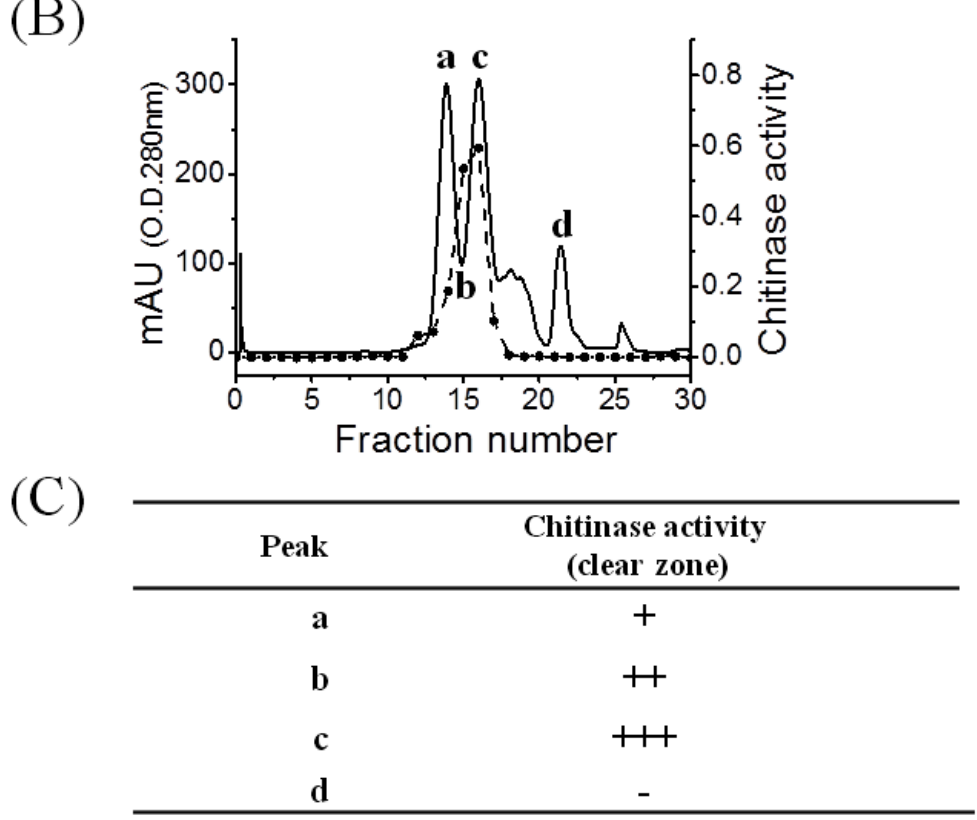
Figure 2. Purification of chitinase 1198 from recombinant Escherichia coli. ( A ) Lane E2, elution of chitinase 1198 from Ni-column purification. Lanes a–d, di ff erent fractions collected from gel-filtration purification. ( B ) Gel-filtration chromatography on a Superose 12 30 / 300 GL of E2 following Ni-column purification of chitinase 1198. Dashed line = chitinase activity of di ff erent fractions by using p-NP-(GlcNAc)2 as a substrate. ( C ) Chitinase activity from Superose 12 30 / 300 GL. Chitinase activity was defined as the ability to hydrolyze a chitin-containing plate to generate a clear zone. Diameters of clear zone < 1 cm, approximately 1 cm, and > 1 cm were designated as + , ++ , and +++ , respectively.